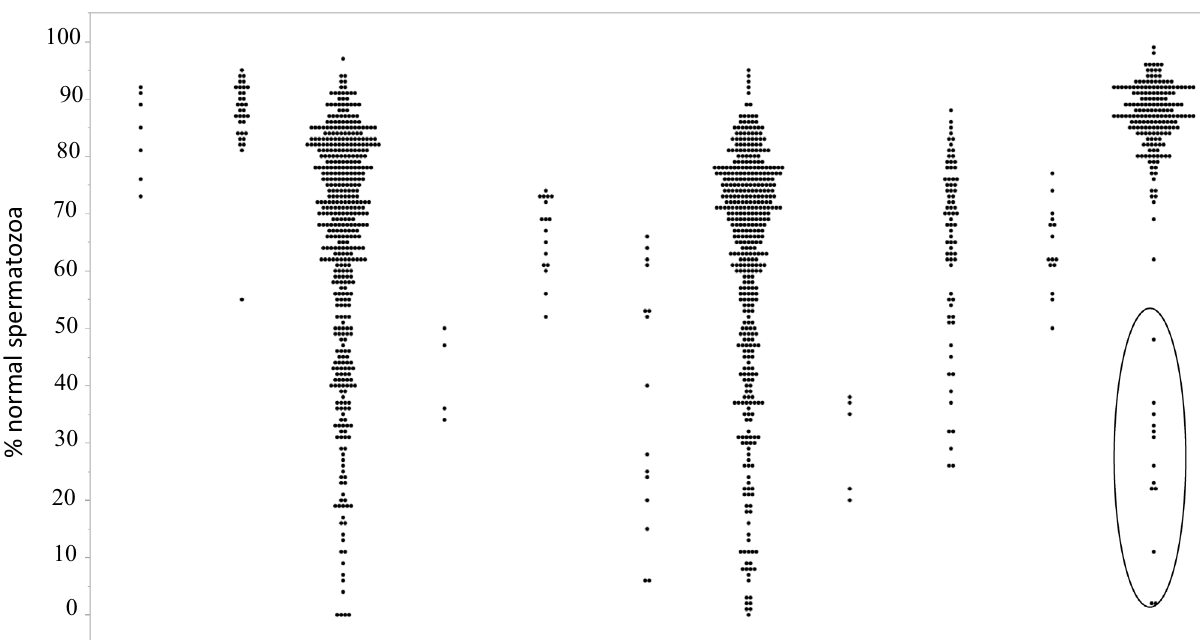
Figure 3. Variation in Semen quality as judged by Bull breed. Semen sample was collected and analysed for sperm morphology. The animals were then separated according to breed and the percentage normal forms for each ejaculate are